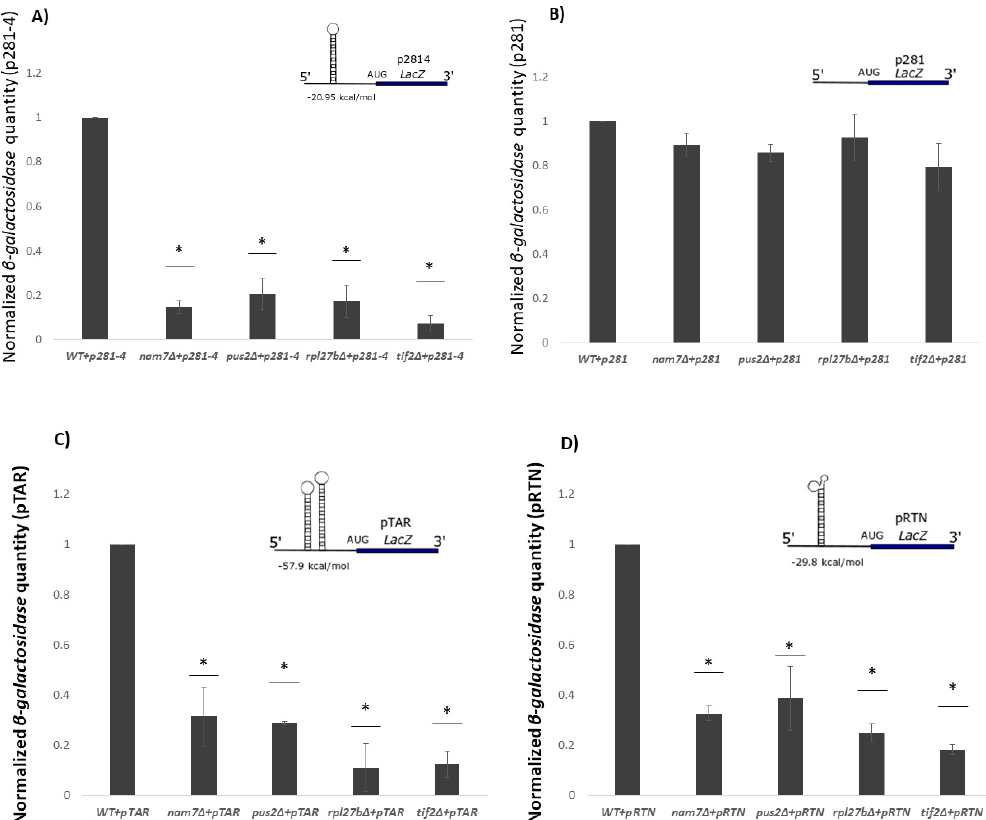
Figure 5. β -galactosidase expression analysis in di ff erent yeast strains. ( A ) Activities from β -galactosidase mRNAs that carry a strong hairpin structure (p281-4) upstream of a LacZ reporter were highly reduced in nam7 ∆ , pus2 ∆ , and hal1 ∆ strains. ( B ) Our control plasmid (p281) with no inhibitory structure did not show reductions in β -galactosidase activity. pTAR ( C ) and pRTN ( D ) constructs contain the highly structured 5 (cid:48) -UTR of HIV-tar1 and FOAP-11 genes, respectively, in front of the β -galactosidase reporter mRNA showed significant reduction in mutant strains. Values are normalized to that for WT, which resulted in average β -galactosidase values of 14.1 U and 37.9 U for pRTN and p416 constructs, respectively. Each experiment was repeated at least three times ( n ≥ 3) and error bars represent standard deviation. * represent statistically significant results ( p -value ≤ 0.05) compared to the WT. t -test analysis ( p -value ≤ 0.05) was used to compare di ff erences. The insets represent schematic reporter mRNA structures.